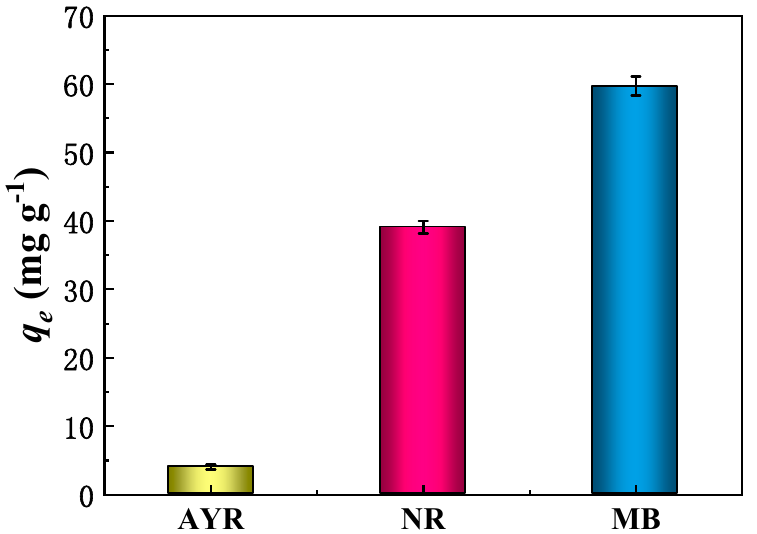
Figure 8. Adsorption capacity of CPP200 toward different dyes in aqueous solutions (dye concentration of 50 mg/L, adsorbent dosage of 5.0 mg and contact time of 90 min, T = 25 °C). FT-IR analyses indicated that CPP200 possessed abundant oxygen-containing func-